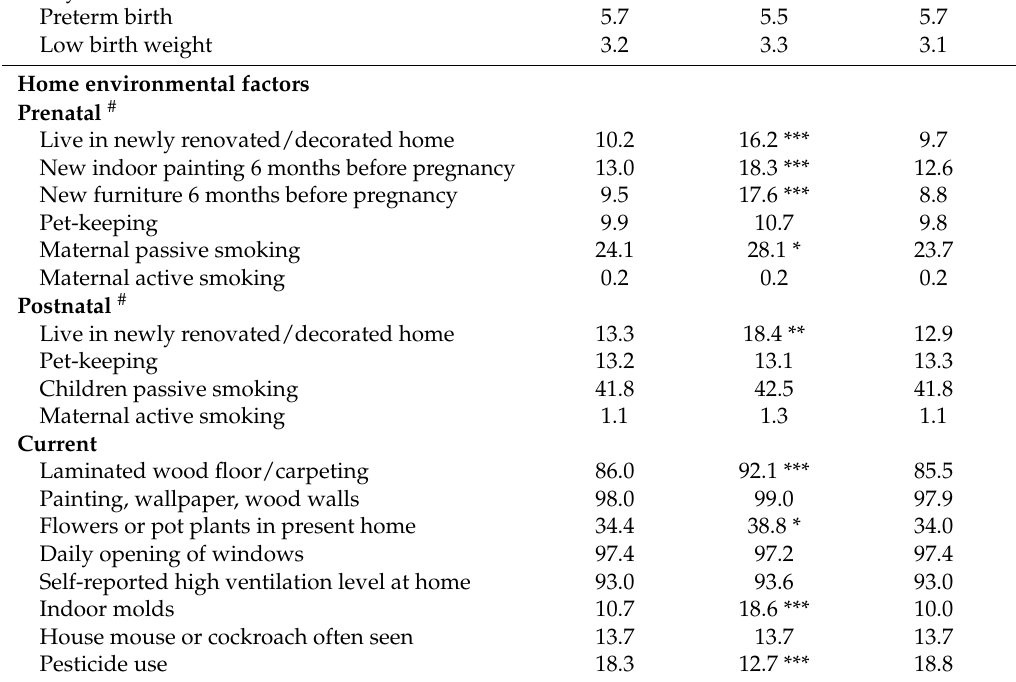
Total With AD Without AD ( n = 6624) ( n = 560) ( n = 6064) 8.5 – –